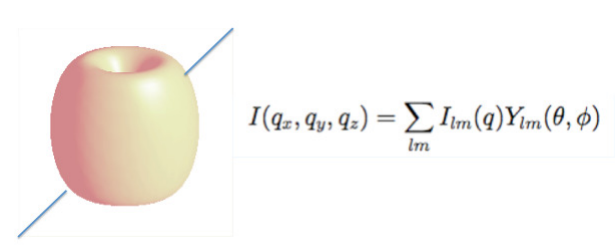
Figure 3. Expansion in spherical harmonics with respect to an arbitrary axis.